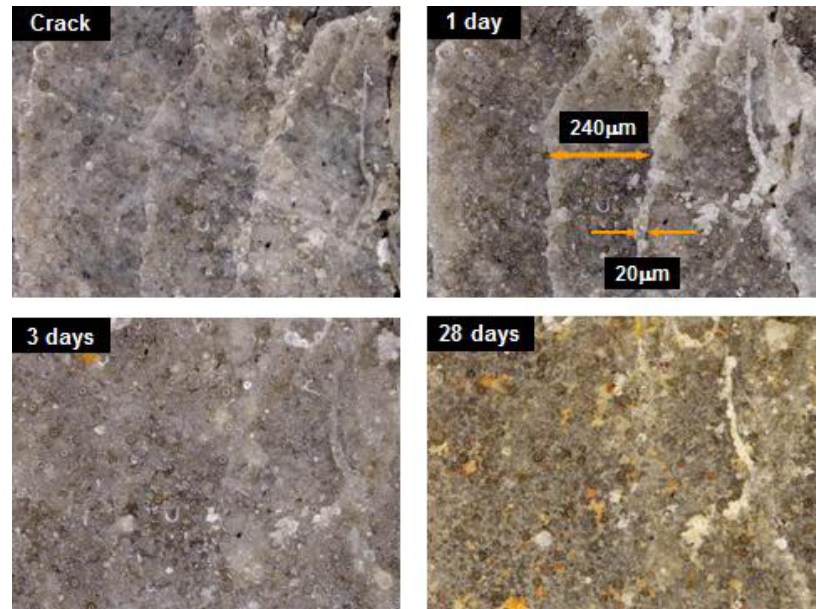
Figure 11. Process of self-healing in matrix B with 2% twisted